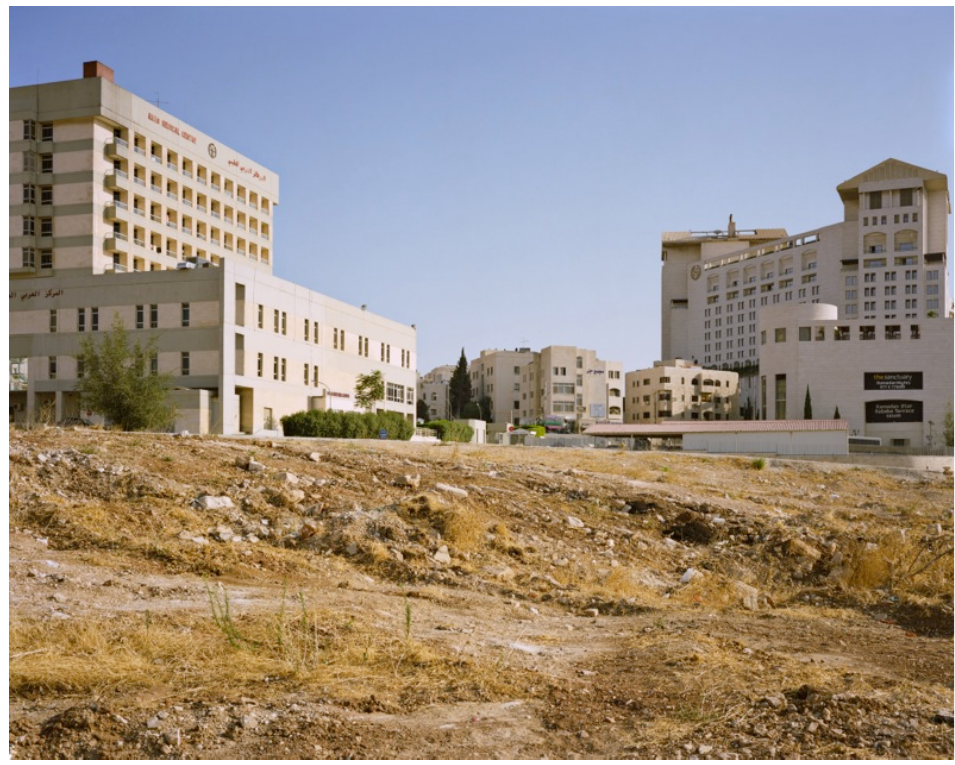
Regina Mamou, Untitled (Near Fourth Circle) from the series Mapping Collected Memory , 2009–2010. Digital C-print. 40 x 50 in. (101.60 x 127